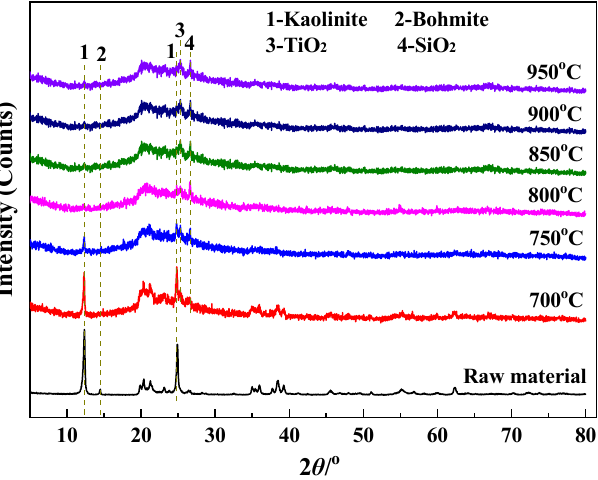
Figure 9. XRD analysis of calcined kaolin products.